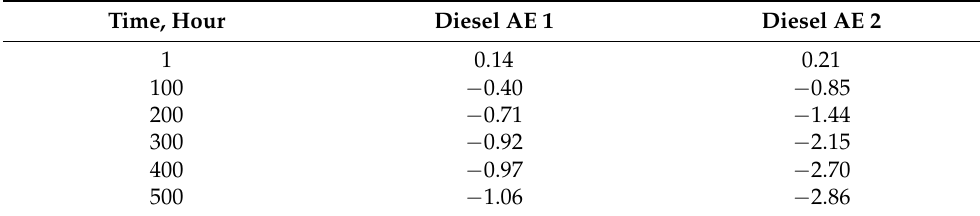
Table 6. Relative percentage change in compression pressure, diesel engine 5L23/30 MAN-B&W Diesel Group under different experimental conditions.